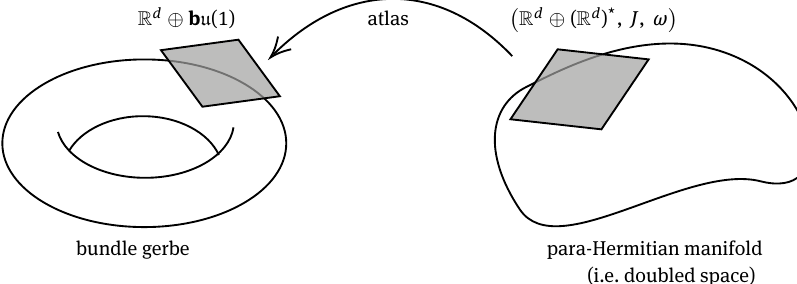
Figure 1: para-Hermitian geometry (i.e. the geometry of doubled spaces) as atlas description of bundle gerbes.